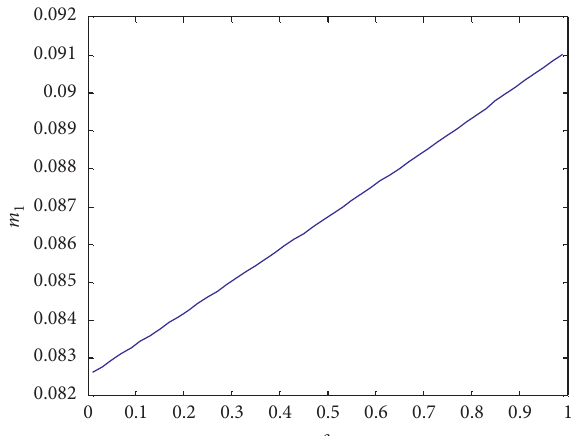
Figure 5: Relationship between SMEs’ effort and CDS loss